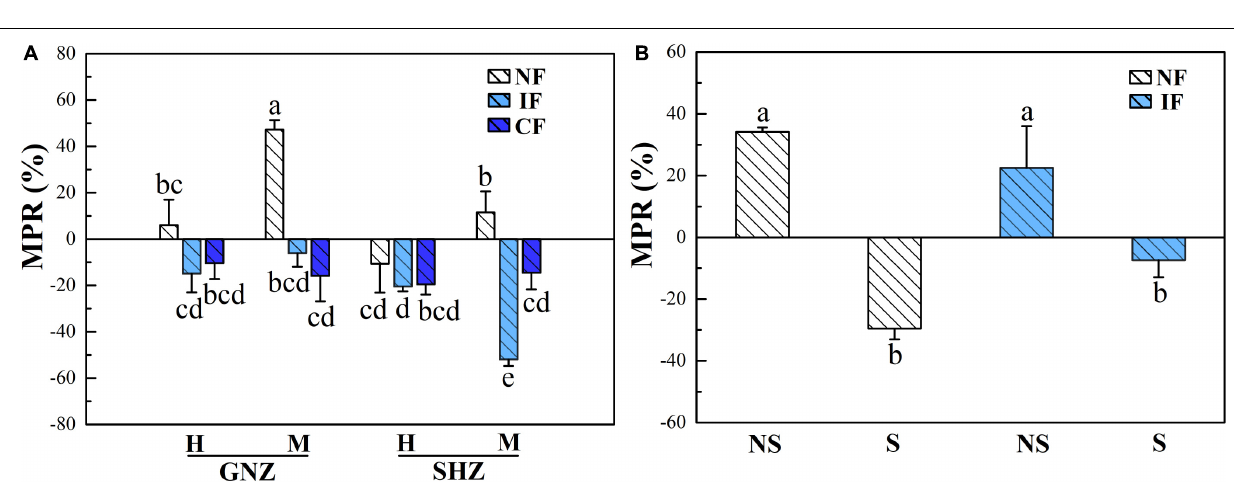
Frontiers in Microbiology |